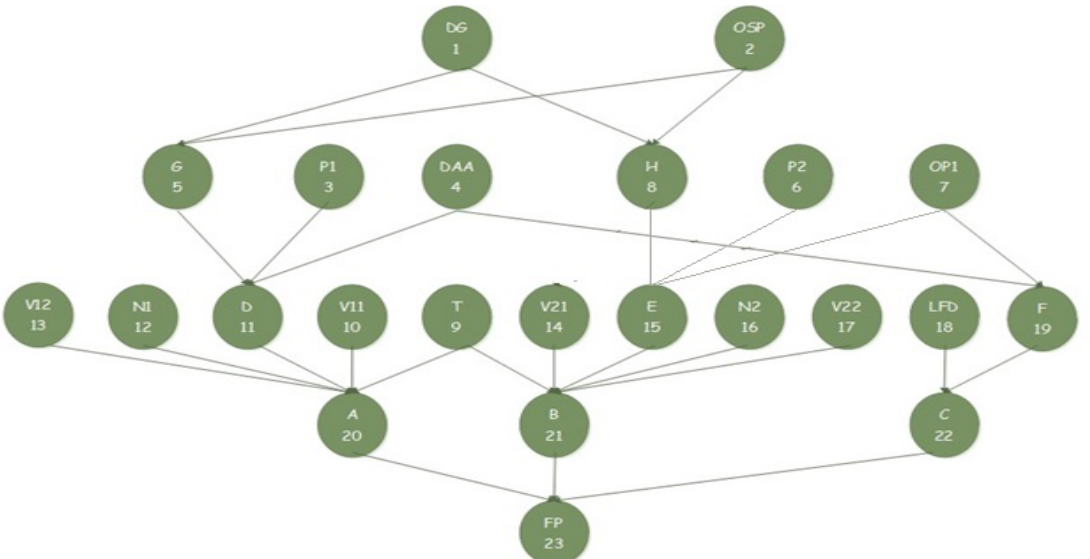
Figure 6. Conversion of a fault tree to a Bayes network in the automatic fire sprinkler